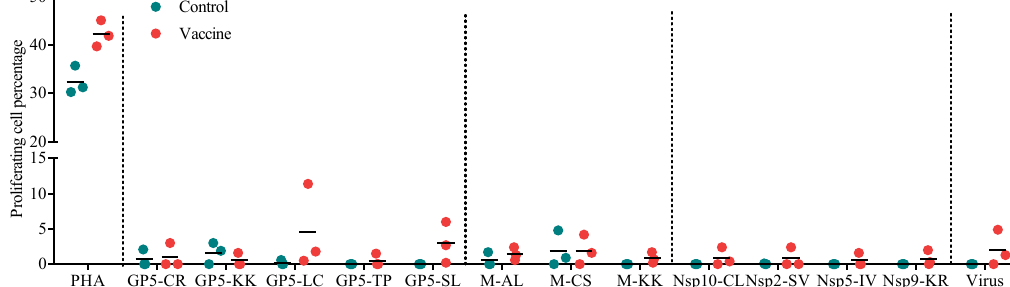
Figure 3. Proliferation of PBMCs from immunized pigs in response to structural and nonstructural peptides and PRRSV. The results were obtained by subtracting the percentage of proliferating cells observed with the unstimulated cells from the percentage observed with the stimulated cells.